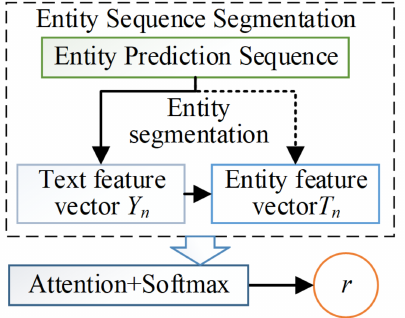
Figure 8. Algorithm diagram of multi-entity segmentation relation extraction.